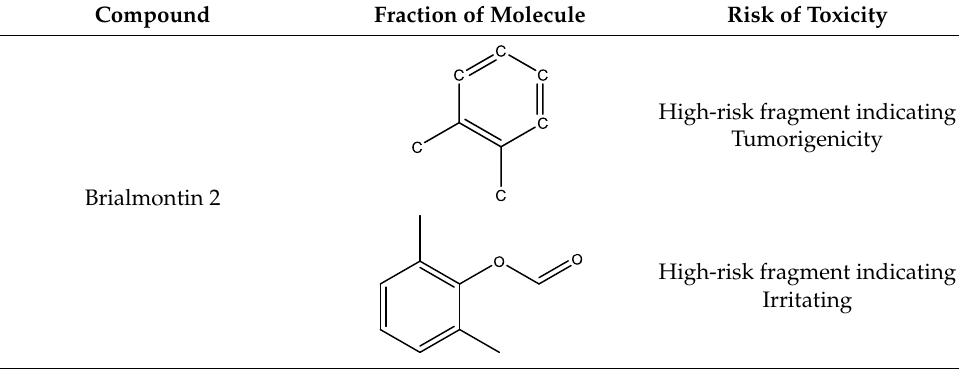
Table 9. Structural fragments responsible for toxicity in the extracted compounds from Lecania brialmontii .